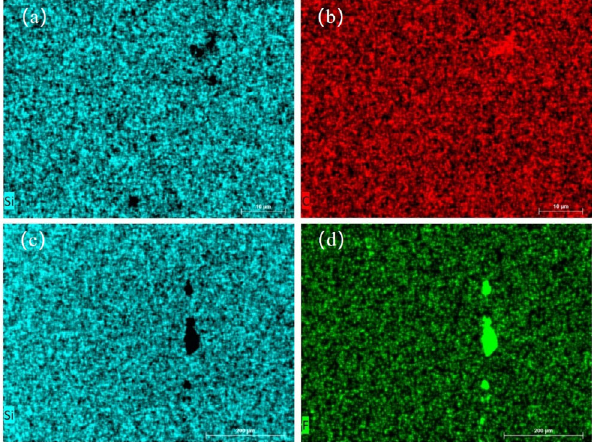
Fig. 7 EDS analysis of the silicon surface. (a) Si and (b) C elements on Fig. 6 (e); (c) Si and (d) F elements on Fig. 6(f).